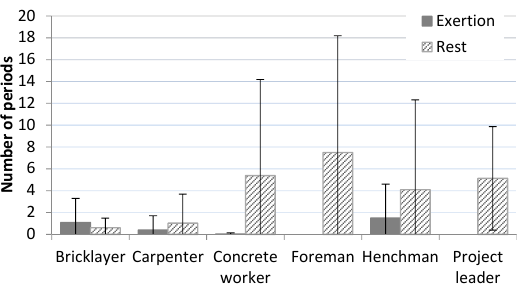
Figure 4. Number of episodes with mean RHR above 33% (exertion) or below 10% (rest) continuously for 5 min or more.